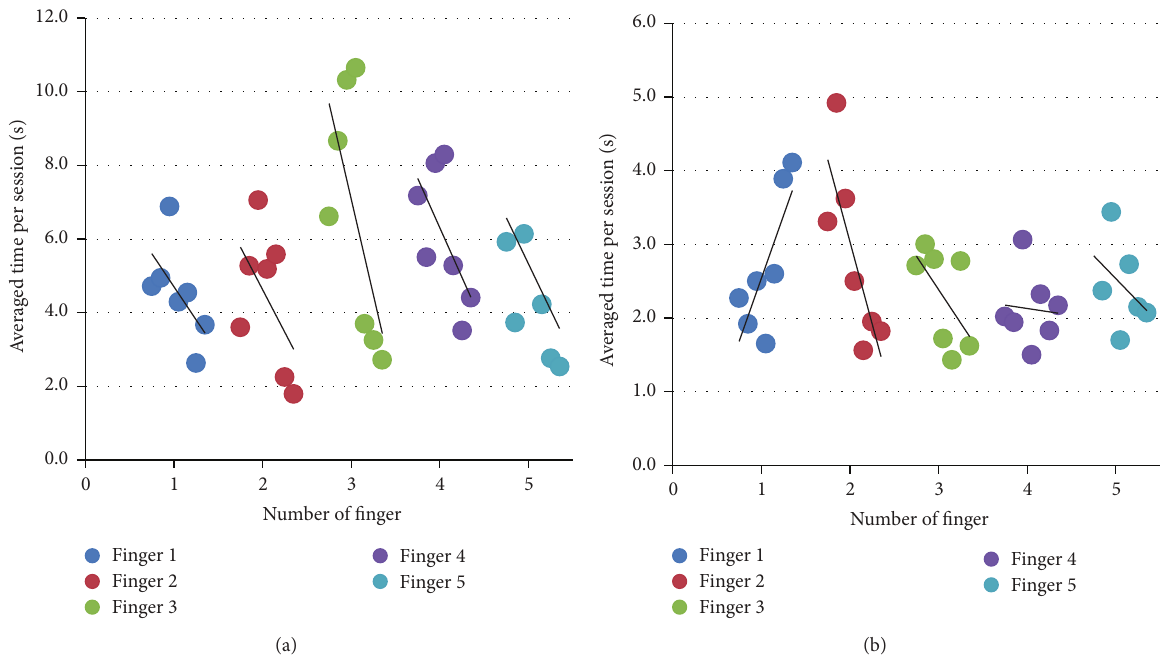
Figure 3: Exemplary analysis of the average times between the start of vibration in the finger and the response ((a) = nondominant hand and (b) = dominant hand). Each individual point describes a training day and the black line shows the fitted